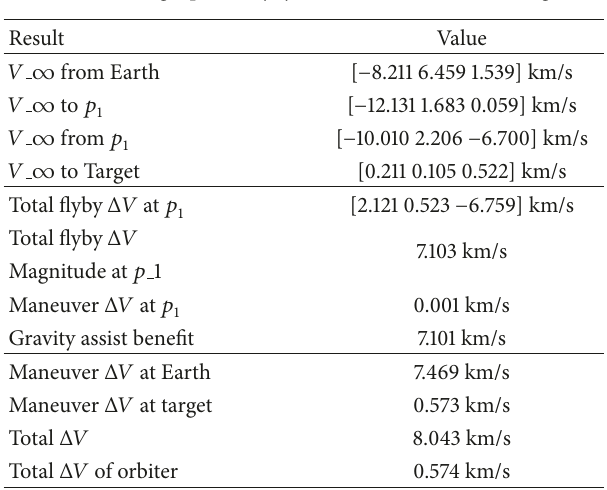
Table 12: Single planet flyby results from Earth to